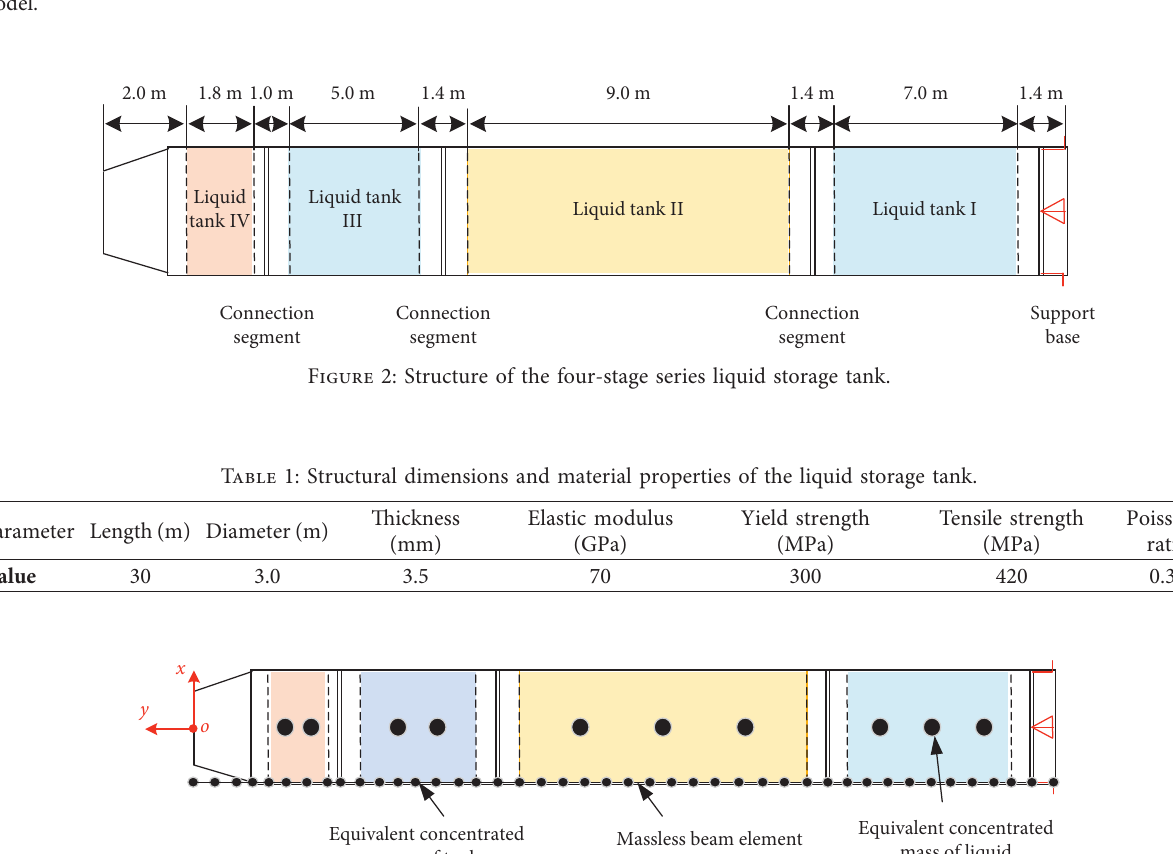
Figure 1: Three-mass-block model of the single-stage liquid storage tank. (a) Structure diagram. (b) Mechanical model. (c) Calculation model.